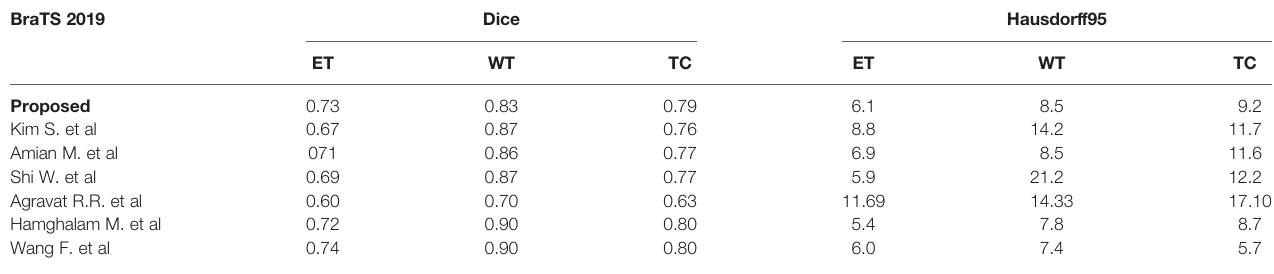
TABLE 4 | Comparison with the BraTS 2019 validation set of other methods. BraTS 2019 Dice